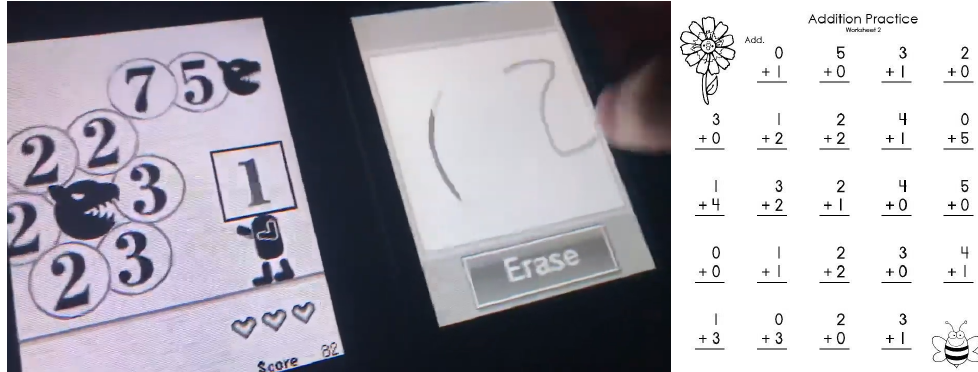
Figure 4. ( Left ) Brain Age 2. Sum Totaled. Player writes ’12’ (7 + 5) to destroy the monster on the top before it fells down and takes one of the three lives. ( Right ) Traditional addition